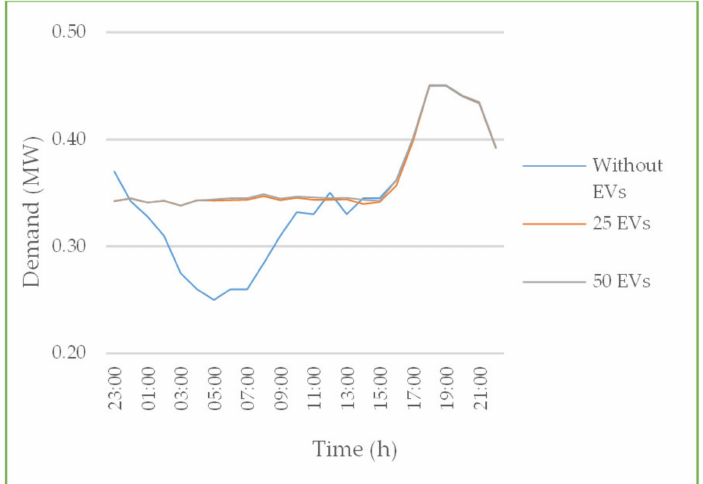
Figure 7. The effect of charging/discharging on LC1 when N = 25 and 50 cars with a random mobility pattern are used for valley filling or peak shaving.